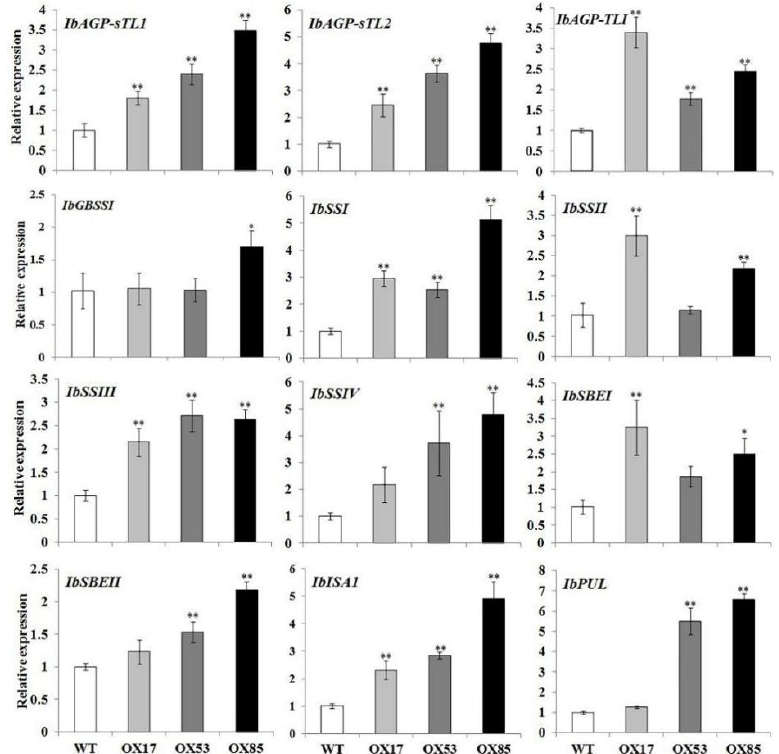
Figure 7. Relative expression levels of the starch biosynthesis related genes in the IbpPGM - overexpressing (OX) transgenic and wild-type (WT) sweet potato lines. IbAGP-sTL1 and -sTL2 , encoding the two small subunits of ADPglucose pyrophosphorylase (GenBank accession number: Z79635 and Z79636); IbAGP-TLI , encoding the large subunit of ADPglucose pyrophosphorylase (AJ252316); IbGBSSI , granule-bound starch synthase I (AB071604); IbSSI , II , III and IV : soluble starch synthase I, II (AF068834), III and IV; IbSBEI and II , starch branching enzyme I and II (AB194725 and AB071286); IbISA1 , isoamylase1 (DQ074643); IbPUL , pullulanase. * and ** indicate a significant difference versus WT at p < 0.05 and <0.01, respectively, based on Student’s t